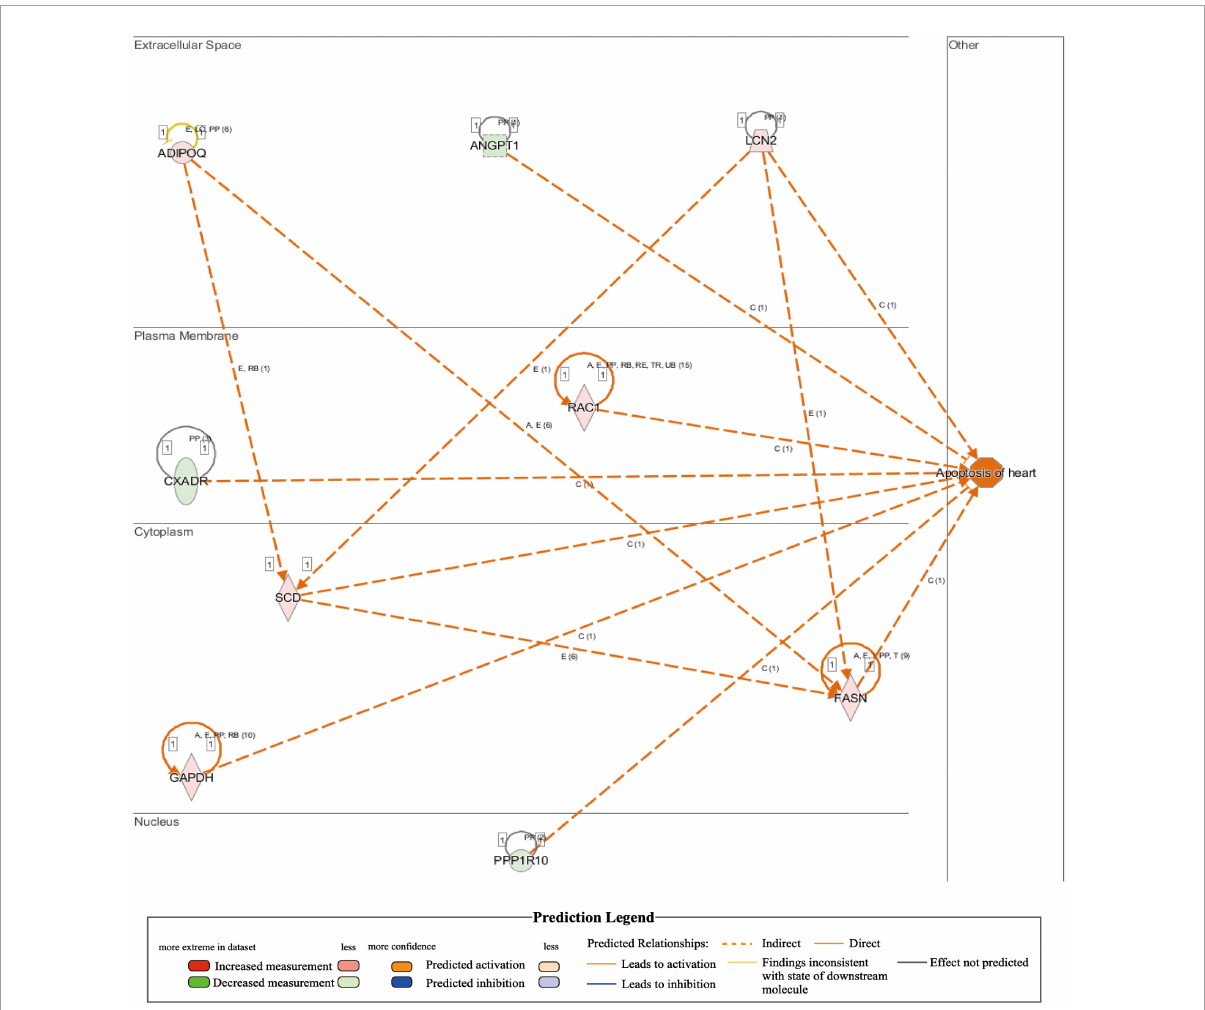
FIGURE6 Activated regulation of heart apoptosis played a role in heart failure induced by loss of cardiomyocyte-derived BDNF: Integrated IPA identified that apoptosis in cardiomyocyte-derived BDNF conditional knockout hearts was higher than that in wild-type hearts ( p -value = 2.06E-02; activation z -score = 2.028). The interaction network demonstrated that 9 genes (6 upregulated genes and 3 downregulated genes) were included that were involved in the activation of apoptosis in cardiomyocyte-derived BDNF conditional knockout hearts. The shown interaction network only showed the predicted interaction by IPA analysis. Other interaction networks shown in this study are presented as the same